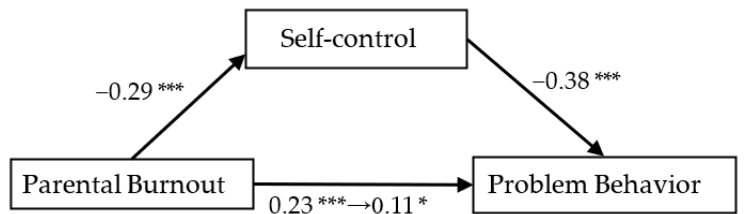
Figure 4. The mediating effect of self-control on parental burnout and problem behavior. * p < 0.05, *** p < 0.001.